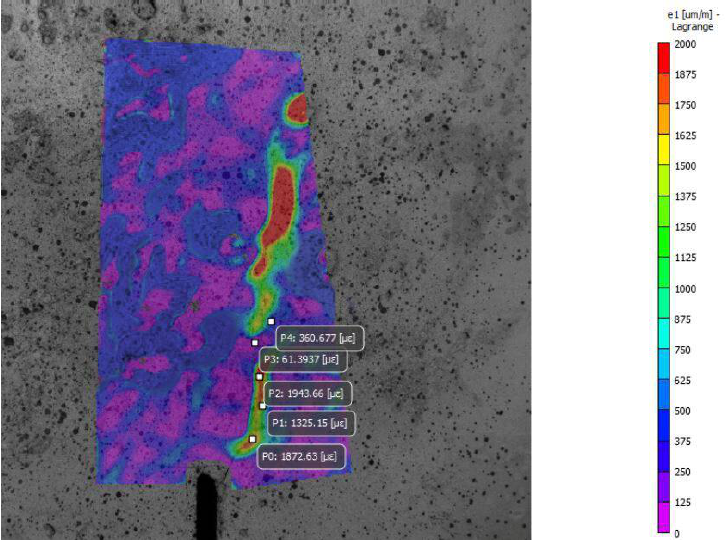
Figure 8. Example of contour plot and strain values along principal direction 1 obtained by